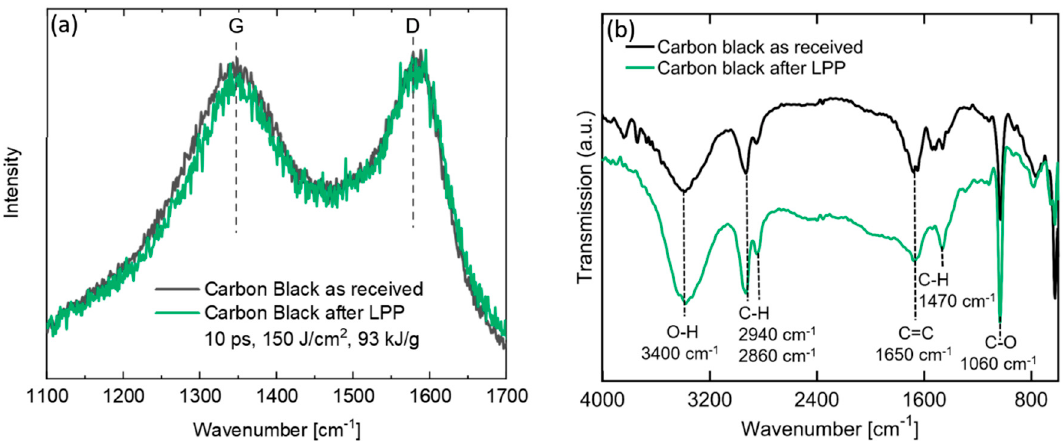
Figure 4. ( a ) Representative spectra from samples analyzed by Raman spectroscopy (3 measurements each), showing the two relevant peaks at 1590 cm − 1 (G-Band) and 1350 cm − 1 (D-Band) for carbon nanoparticles before and after irradiation with the highest fluence (10 ps, 150 mJ/cm2). ( b ) Fourier transform infrared spectroscopy (FTIR) spectra of the as-received and laser-irradiated carbon black, where the surface bonds identified by the absorption peaks are marked with a dotted line. In both cases the spectra displayed represent carbon nanoparticles before and after irradiation with the highest fluence (10 ps, 150 mJ/cm 2 ).